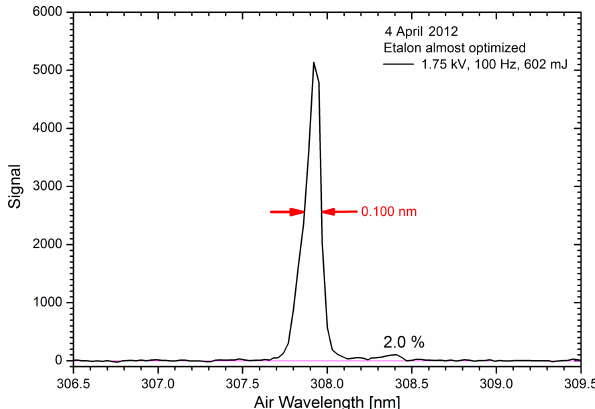
Figure 5. Spectrum of the laser emission with an almost opti- mized etalon angle; the laser was operated at a 10Hz repetition rate, 1.75kV load voltage and 663mJ (including the